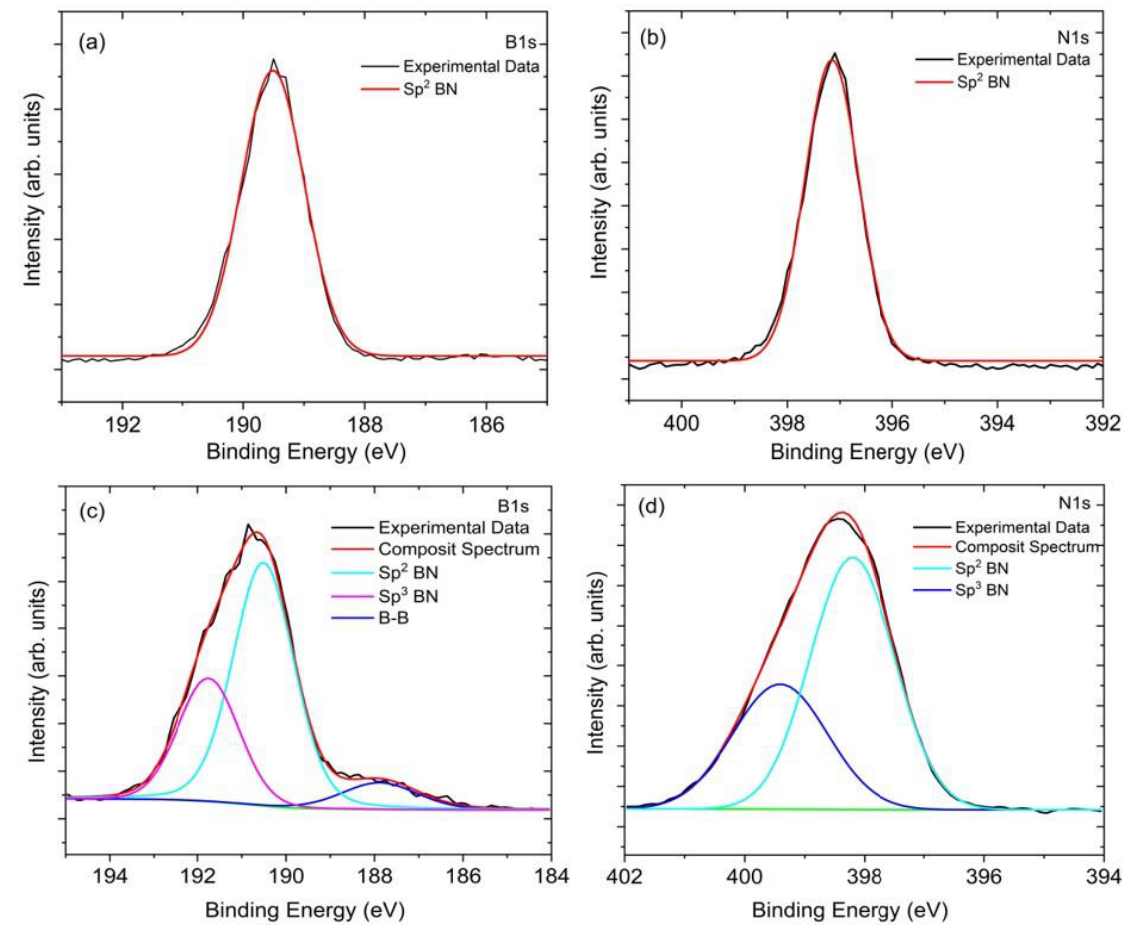
Figure 2. X-ray photoelectron spectra of hi-res ( a ) B1s and ( b ) N1s of without external bias BN coating shows only sp 2 bonded BN. Hi-res ( c ) B1s and ( d ) N1s of bias-enhanced BN coating shows both sp 2 and sp 3 bonded BN on the spectrum. The detailed compositional analysis with corresponding binding energy is shown in Table 2. Table 2. XPS compositional analysis and fitted parameters of B1s and N1s.